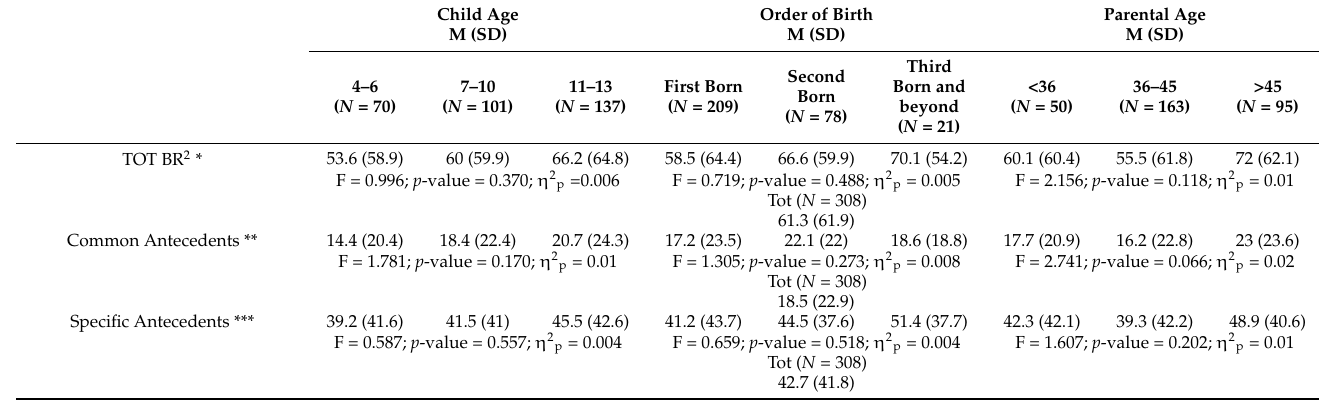
Table 2. Parental distress descriptive data and ANOVA analyses for child age, birth order, and parental age.